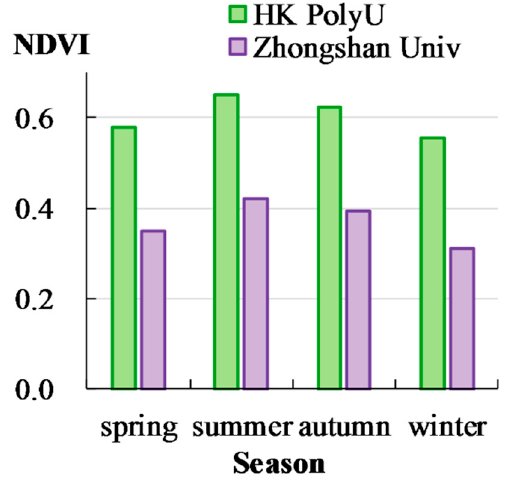
Figure 4. Seasonal distribution of multiyear averaged MODIS NDVI around the “HK PolyU” and “Zhongshan Univ” sites for 2006–2015.